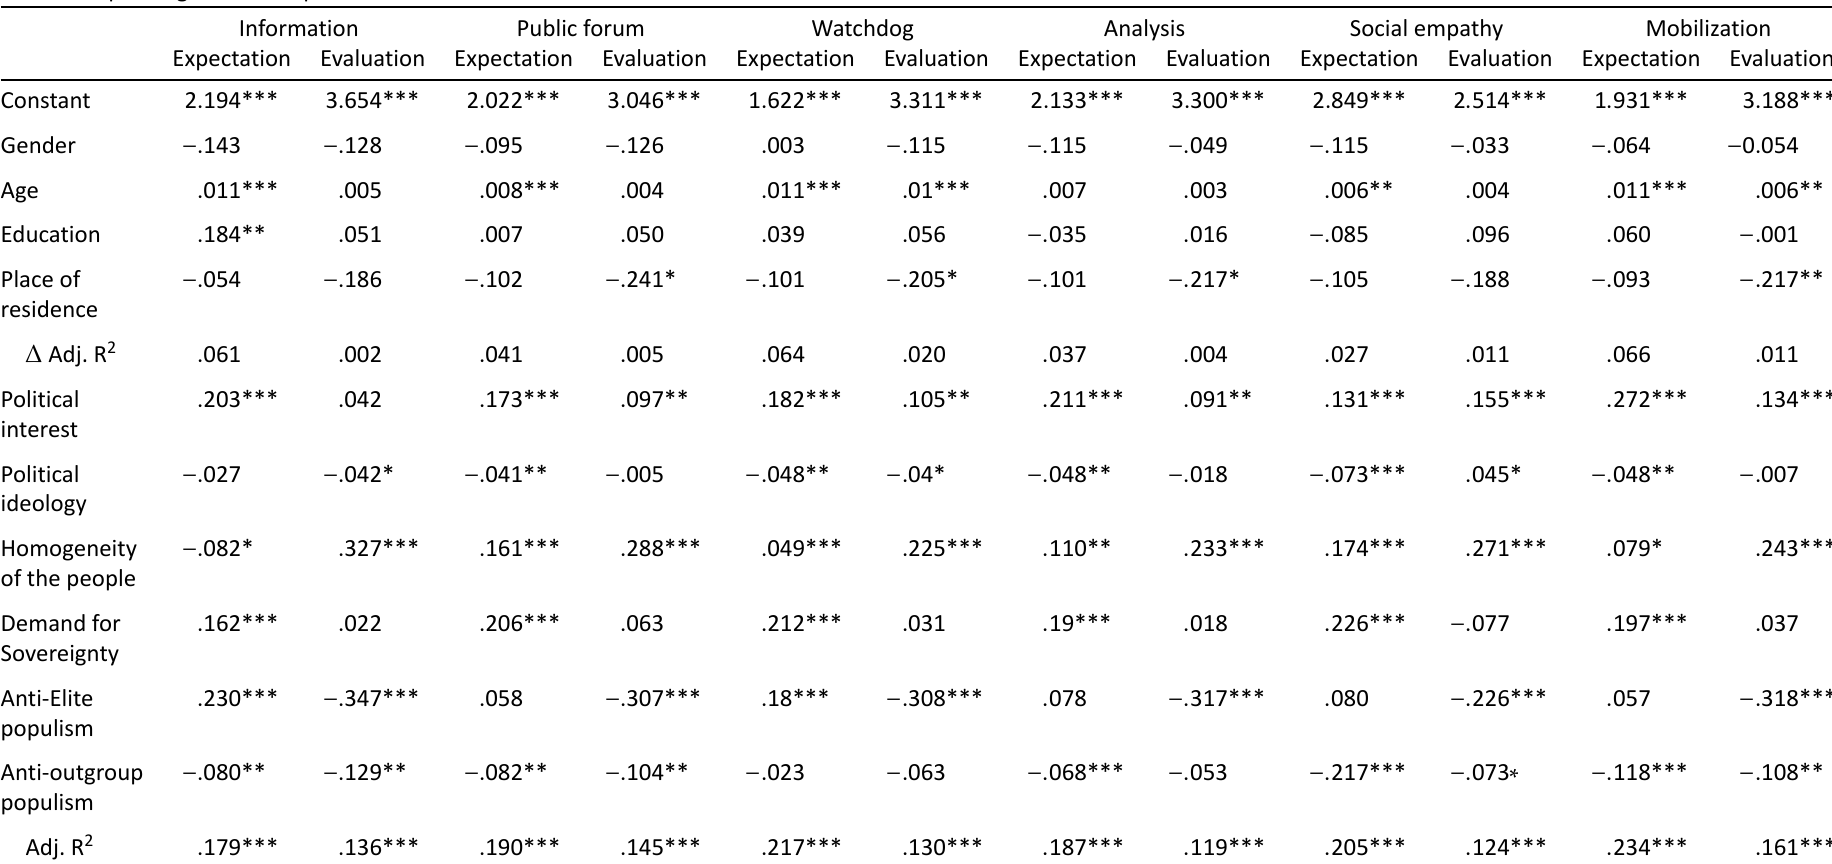
Table 5. Explaining citizens’ expectations and evaluations of six normative media